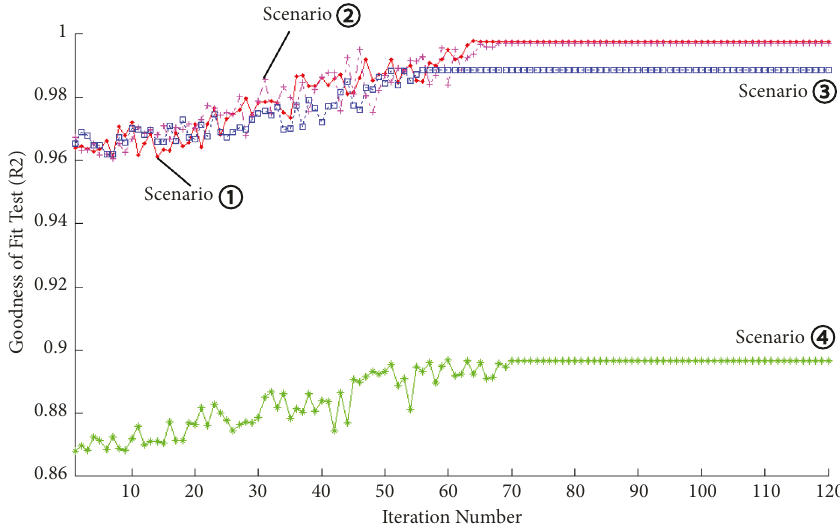
Figure 12: Convergence of the goodness of fit ( R 2 ) for the QOL